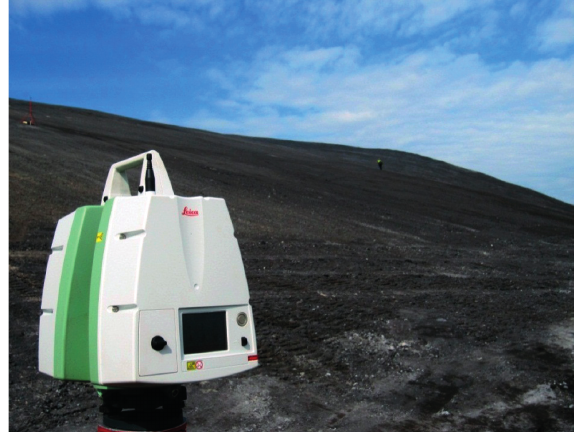
Fig. 3. The used TLS device during the course of the survey (Geo S.T. OÜ 2012)